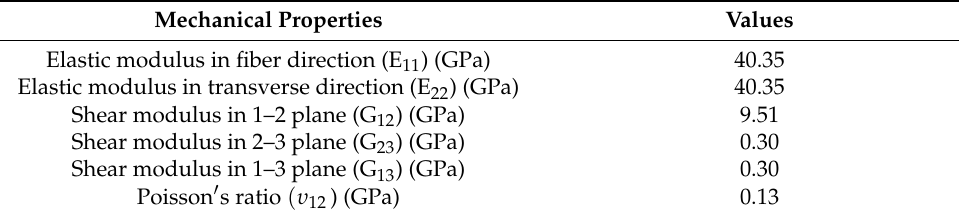
Table 2. Mechanical properties of CFRP